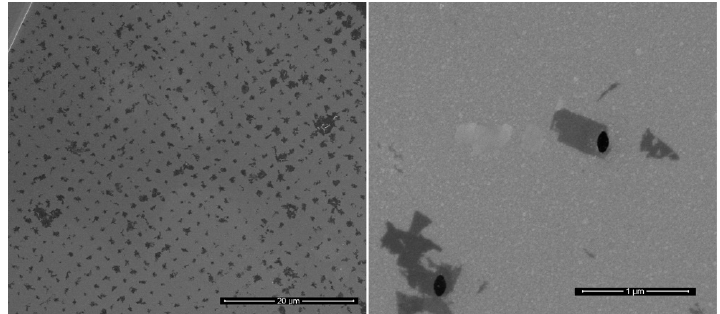
Figure 4. EPD of WS 2 suspended in B ‐ 1.